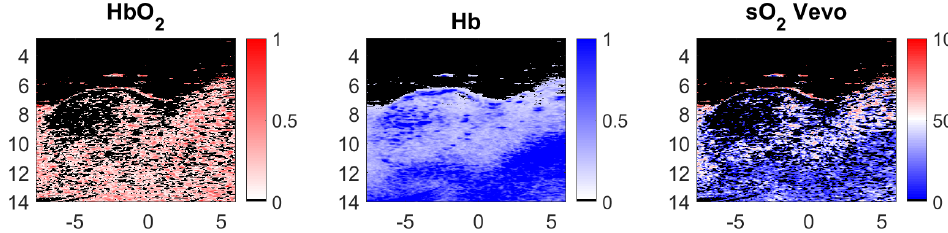
Figure 11. Theoretical Hb and HbO 2 spectra (mean values are: 0.43 and 0.35, respectively).